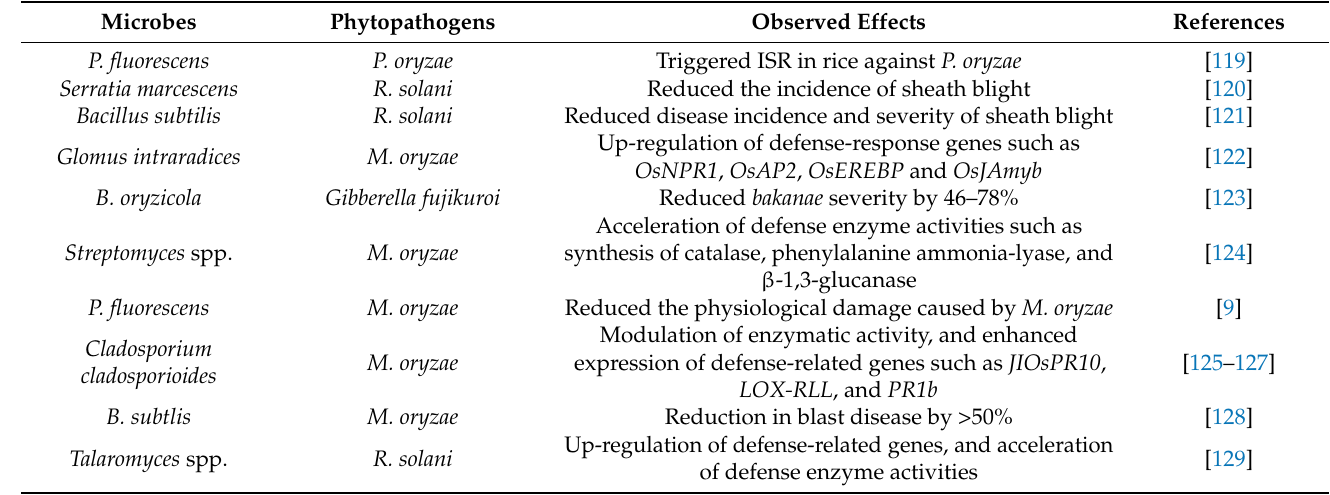
Table 2. Microbes and their biocontrol regulation activities against fungal diseases in